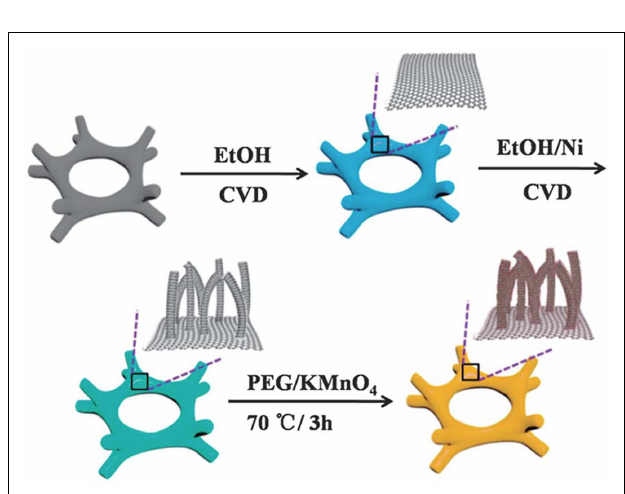
FIGURE 4 | Schematic illustrations of the fabricated 3D MnO 2 –CNT– graphene–Ni hybrids . Adapted with permission from Zhu et al. (2014). Copyright 2014 Royal Society of